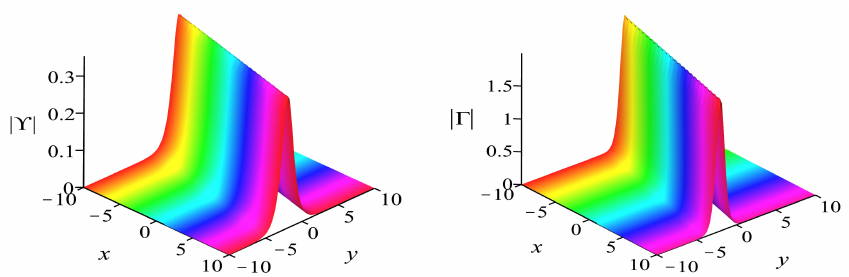
Figure 1. The evolution of solution (35) with α = 0.5, β = γ = ω = B = 2, ν = λ = η = δ = r = 1, σ = − 2, A = − 4, z = − 0.5, and t = 0.1.